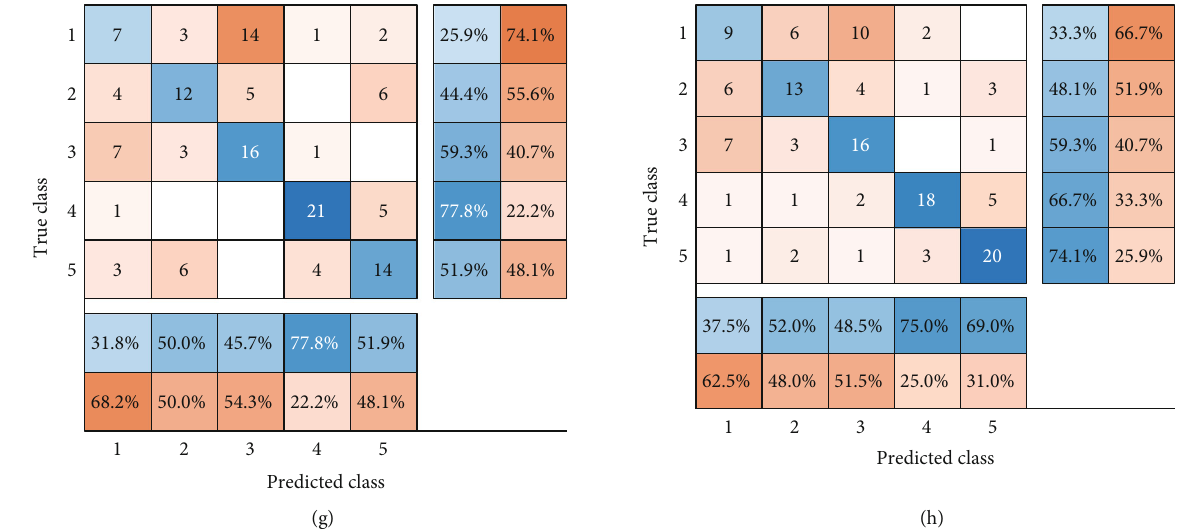
Figure 17: Confusion matrix and recognition accuracy corresponding to the test data of 8 trace